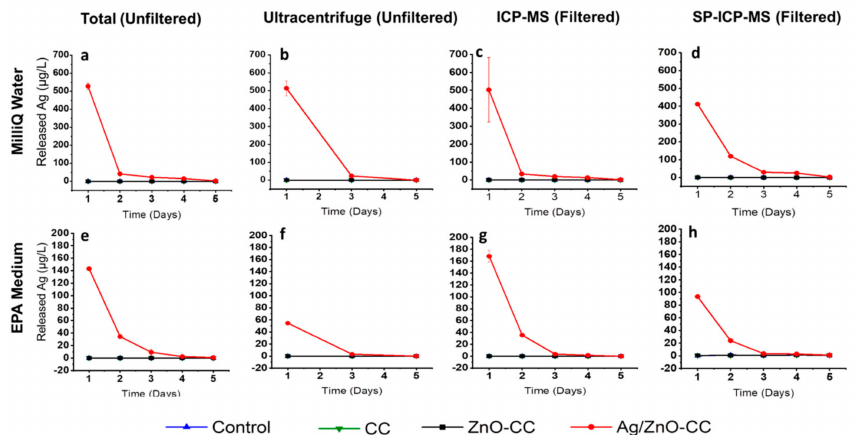
Figure 4. AgNPs / dissolved Ag release from carbon cloth in MilliQ and EPA media. ( a , e ) Total released AgNPs / dissolved Ag. ( b , f ) Dissolved Ag by ultracentrifugation analysis. ( c , g ) Released AgNPs / dissolved Ag analysis in filtered solution using ICP-MS. ( d , h ) Dissolved Ag analysis in filtered solution using SP-ICPMS. (Note: blue line = control, green line = CC, Black line = ZnO-CC are the